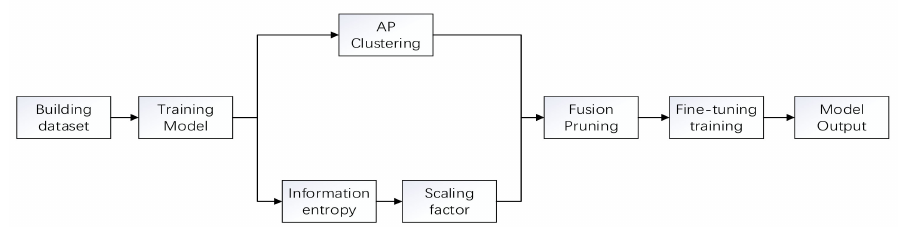
Figure 2. Flow chart of pruning algorithm in this